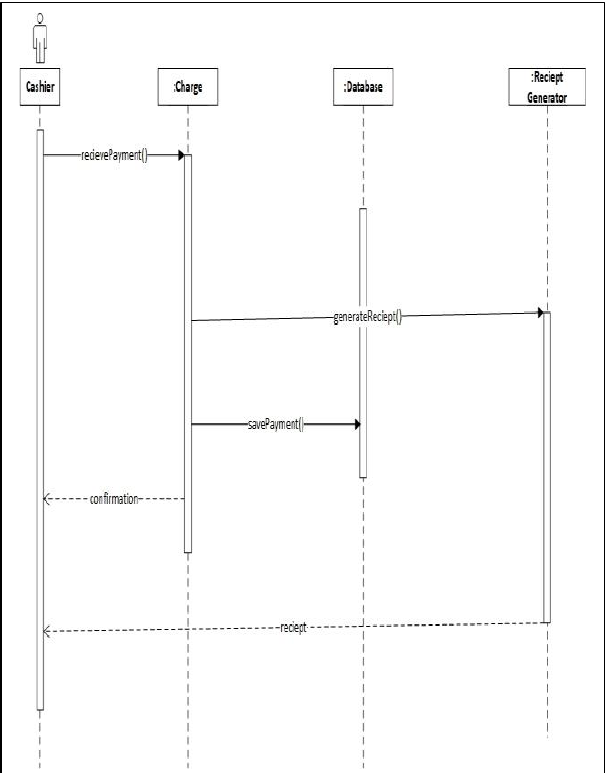
Figure 11. Cashier Sequence Diagram